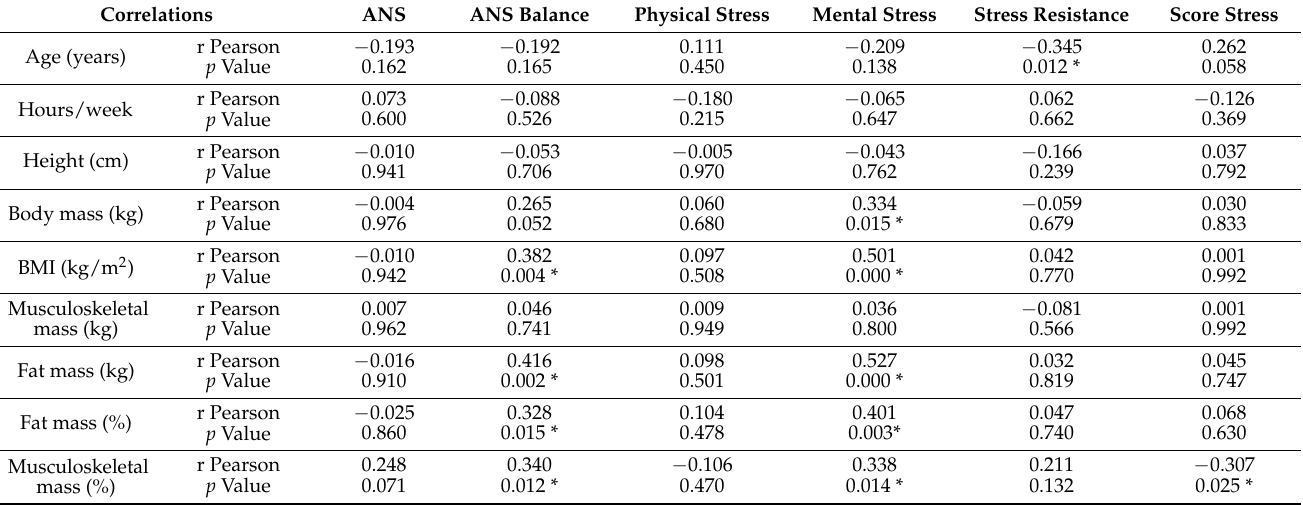
Table 5. Correlations between initial stress variables and general variables.